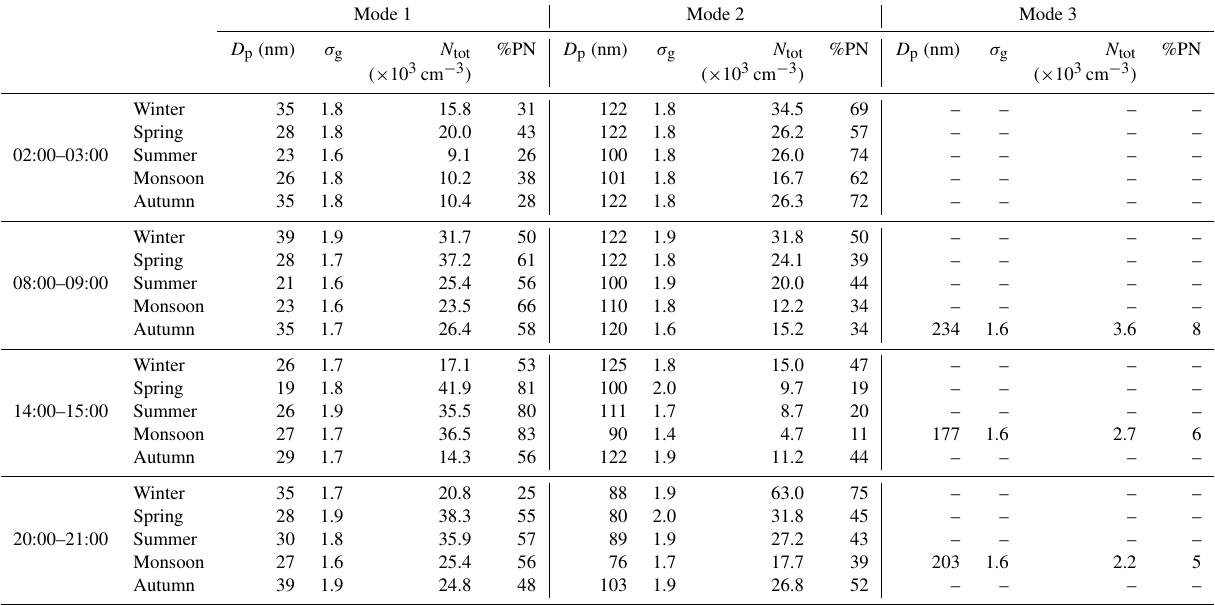
Table 3. Multimodal lognormal fitting parameters for the average particle size distribution of each season and characteristic times of